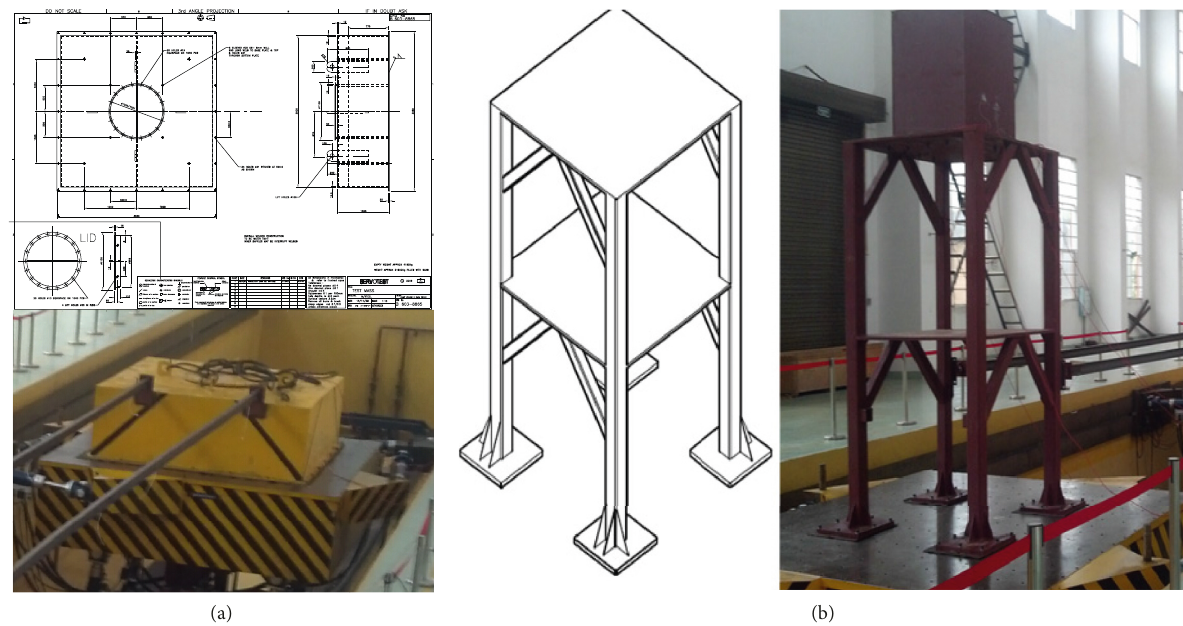
Figure 4: Shake table test with (a) inertia and (b) elastic specimens.